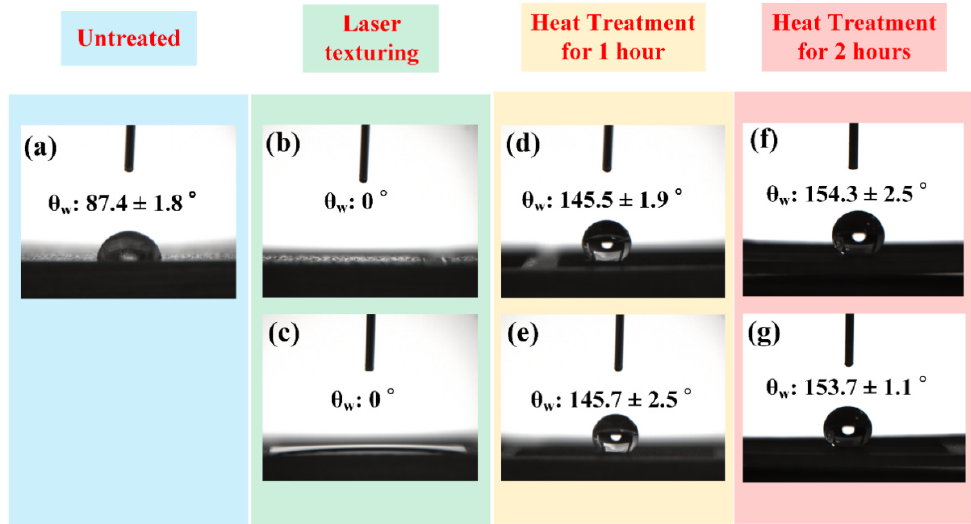
Figure 5. Contact angle measurement results for ( a ) untreated BMG surface; ( b ) laser textured BMG surface using the power of 12 W, the repetition rate of 30 kHz, the scanning speed of 40 mm/s, and a unidirectional surface pattern; ( c ) laser textured BMG surface using the power of 12 W, the repetition rate of 30 kHz, the scanning speed of 40 mm/s, and a cross-hatch surface pattern; ( d , e ) laser textured BMG surfaces in ( b , c ) after heat treatment for 1 h; ( f , g ) laser textured BMG surfaces in ( b , c ) after heat treatment for 2 h.